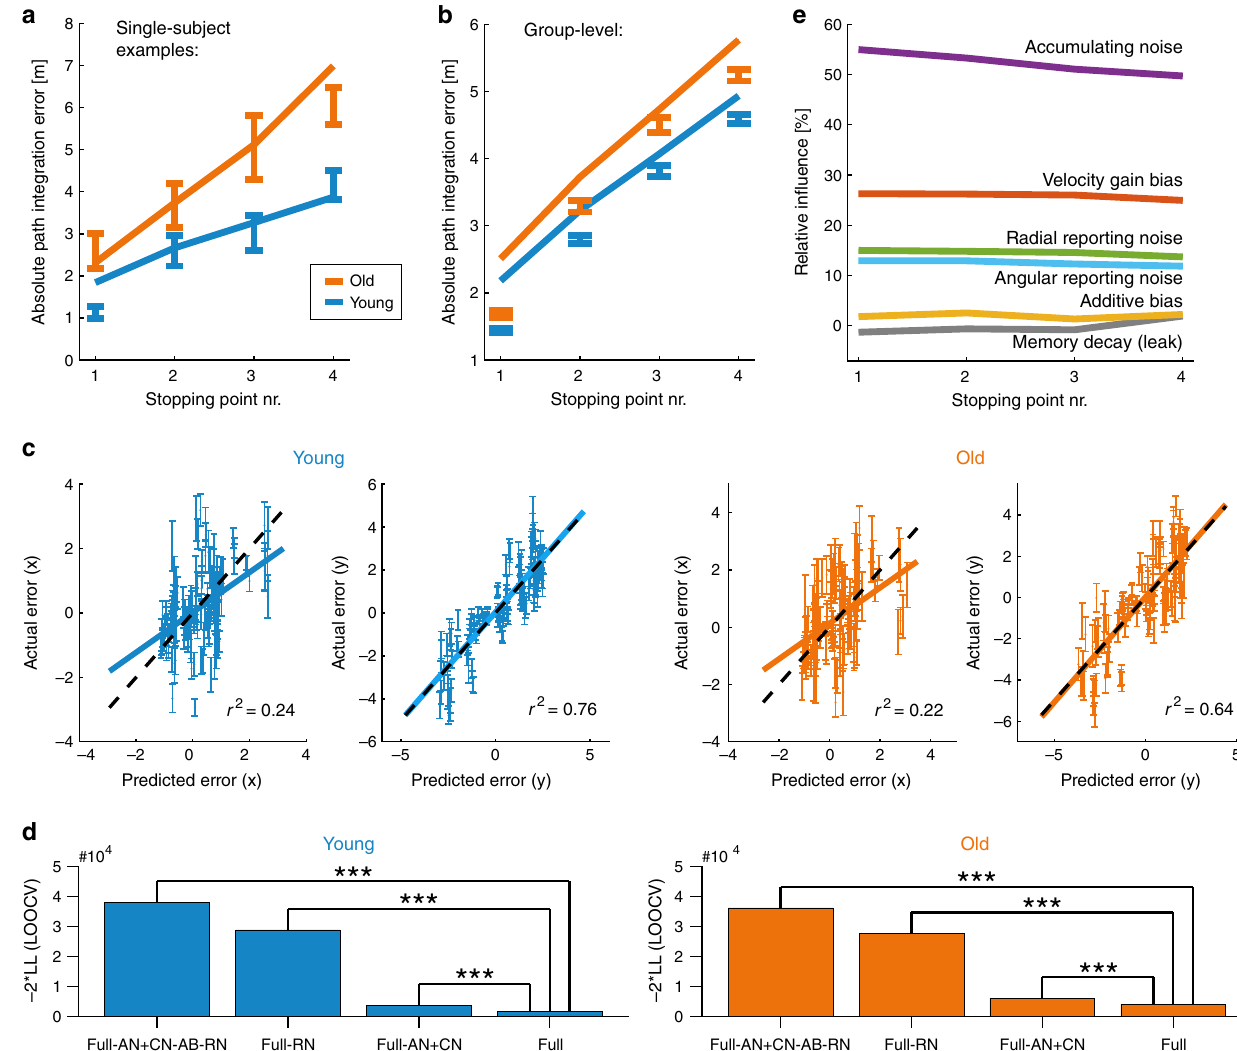
Fig. 3 Computational modeling results. a Path integration errors of two example participants (error bars) versus model fi ts (solid lines). Error bars represent mean ± SEM over trials. See Supplementary Fig. 2 for all participants. b Average path integration errors per age group (error bars) versus model fi ts (solid lines). Error bars represent mean ± SEM over participants. c Single-trial path integration error vectors versus error vectors predicted by